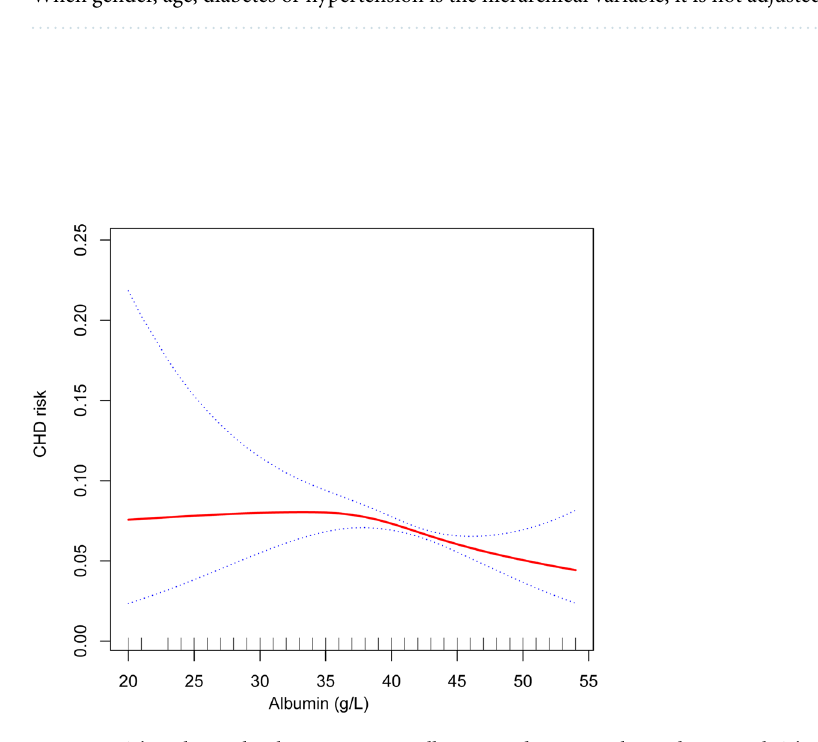
Figure 2. The relationship between serum albumin and coronary heart disease risk. The blue curve represents the 95% confidence interval. Adjust for: gender, age; race, diabetes, HDL-C, hypertension, LDL-C,